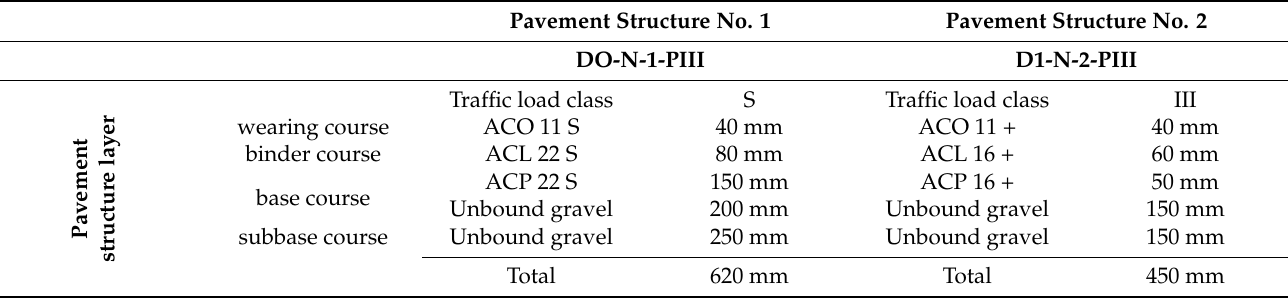
Table 5. Assessed pavement